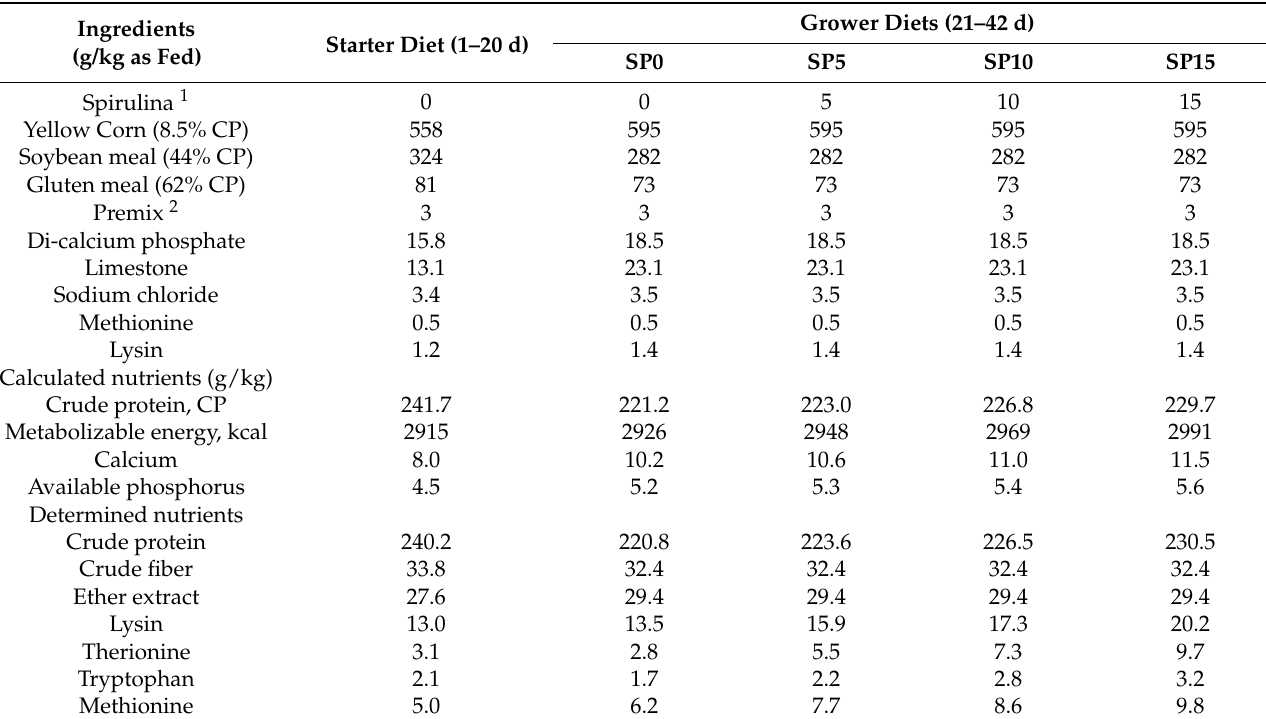
Table 2. Ingredients and nutritional analysis of the